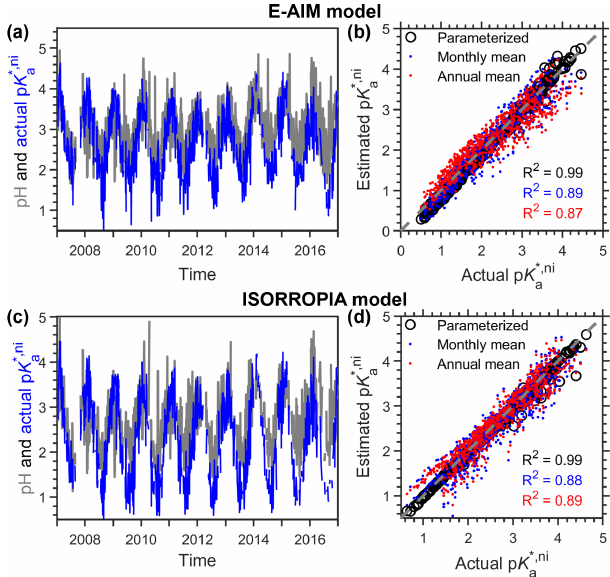
Figure 4. Comparison of pH and actual and estimated p K ∗ based on the 10-year observations in Toronto. Data were taken from Canada’s National Air Pollution Surveillance (NAPS) Program, as detailed in Tao and Murphy (2019). Predications are based on (a– b) the E-AIM model and (c–d) the ISORROPIA model. The “pa- rameterized” series in (b, d) are predicted by the parameterization method proposed with the input of the observed RH, temperature and model-predicted fraction of nitrates in anions. The annual mean and monthly mean are based on mean c ni of an arbitrary example year of